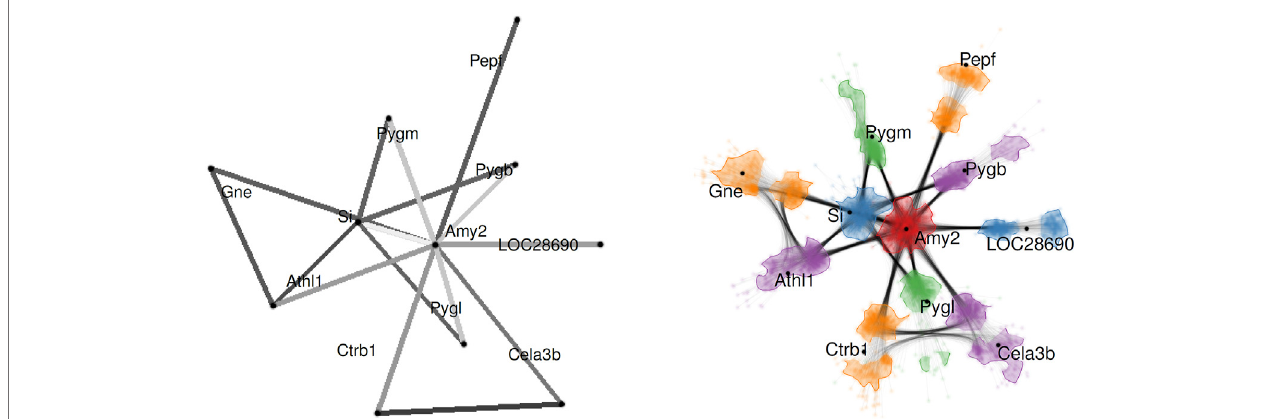
FIGURE 10 | Probabilistic graph layout for visualizing protein – protein interactions for pancreatic alpha-amylase (Amy2). The left image shows the expected (average) graph, i.e., traditional non-uncertainty visualization. The right image shows the uncertainty visualization. Image: © 2017 IEEE. Reprinted, with permission, from Schulz et al. (2017).